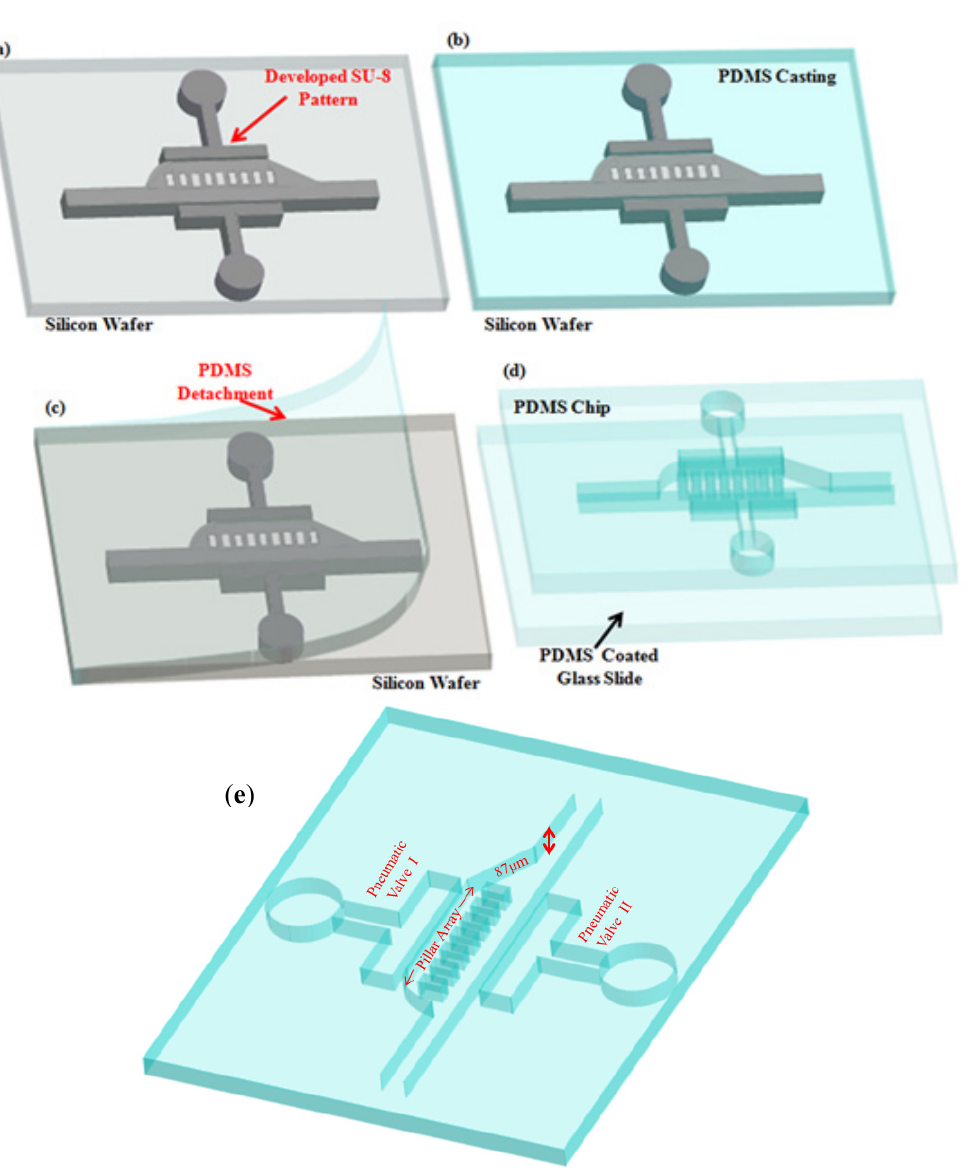
Figure 3. Fabrication process of the droplet merging system ( a ) Su-8 mold ( b ) PDMS casting ( c ) PDMS release ( d ) Plasma bonding ( e ) PDMS